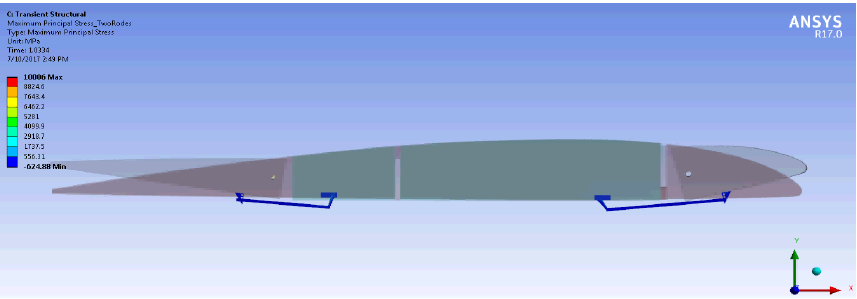
Figure 9. FEA results on the actuation system.